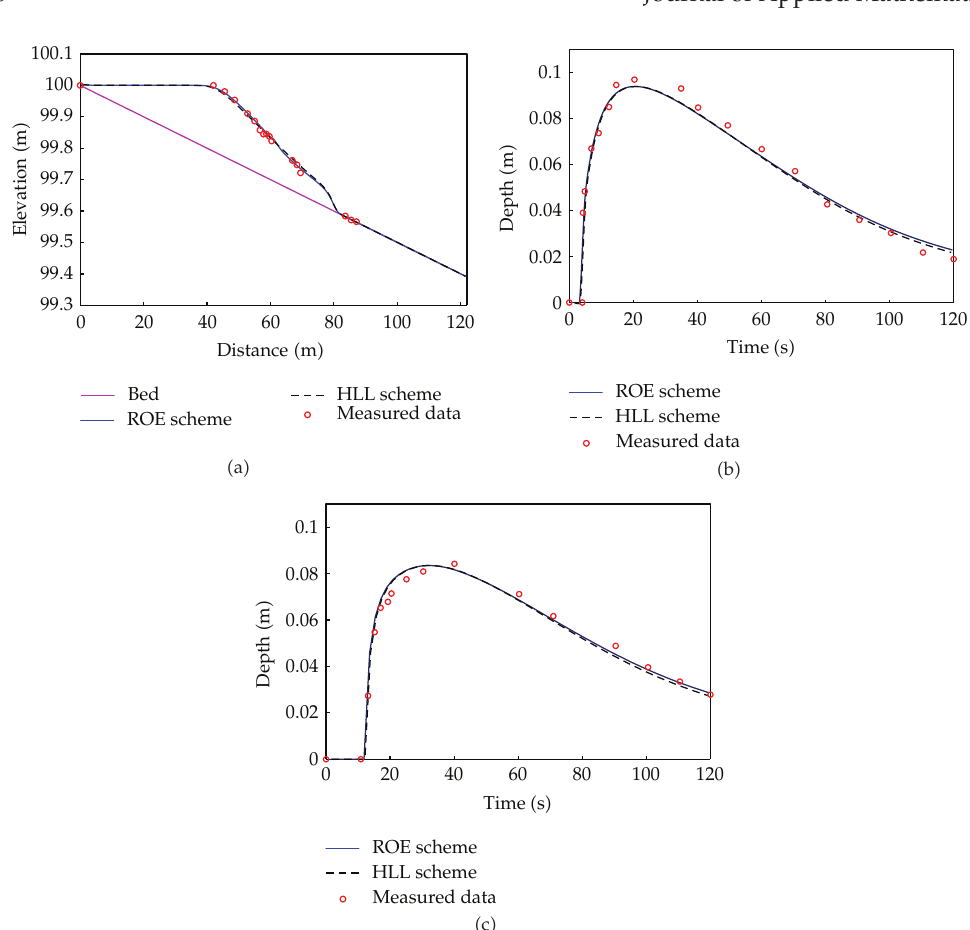
Figure 3: Comparisons with WES experiment: (cid:5) a (cid:6) water surface profile along the channel at t (cid:9) 10sec; (cid:5) b (cid:6) time evolution of water depth at x (cid:9) 70 . 1m; (cid:5) c (cid:6) time evolution of water depth at x (cid:9) 85 .